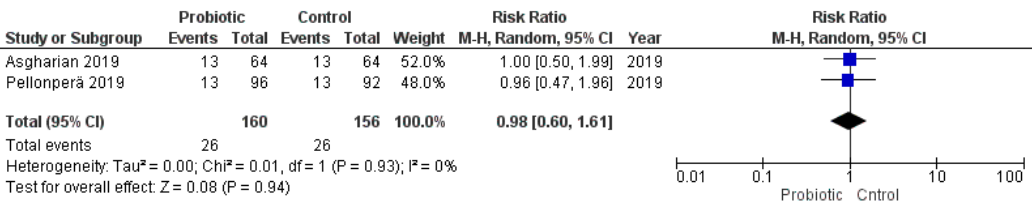
Figure 9. Meta-analysis of studies evaluating the administration of probiotic and large for gestational age.